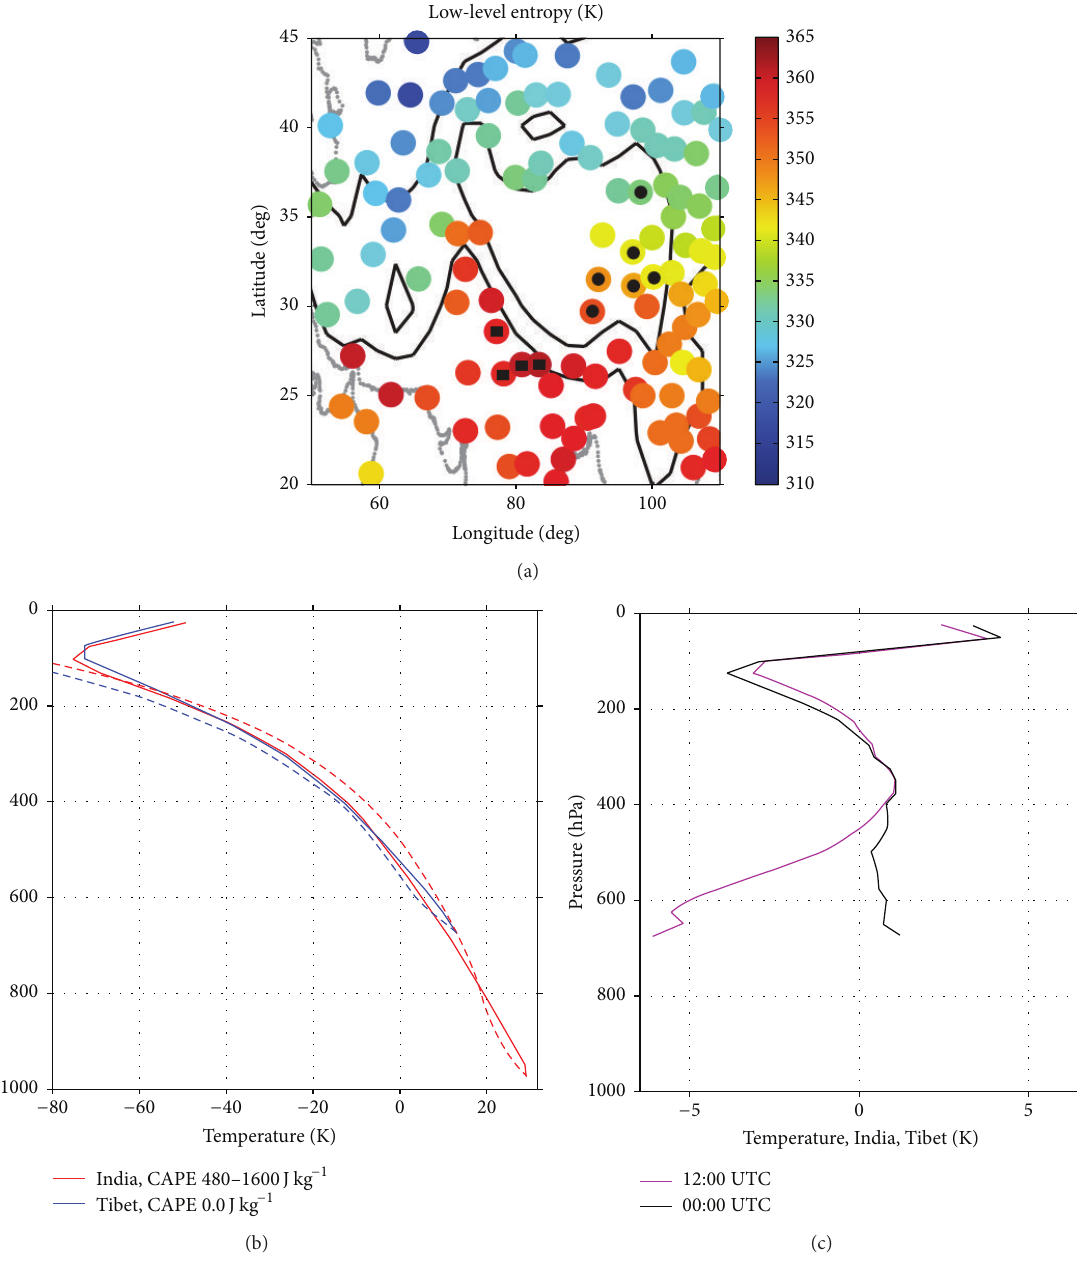
Figure 3: Thermodynamic structure from balloon soundings for June–August. (The figure is cited from Boos and Kuang [22].)